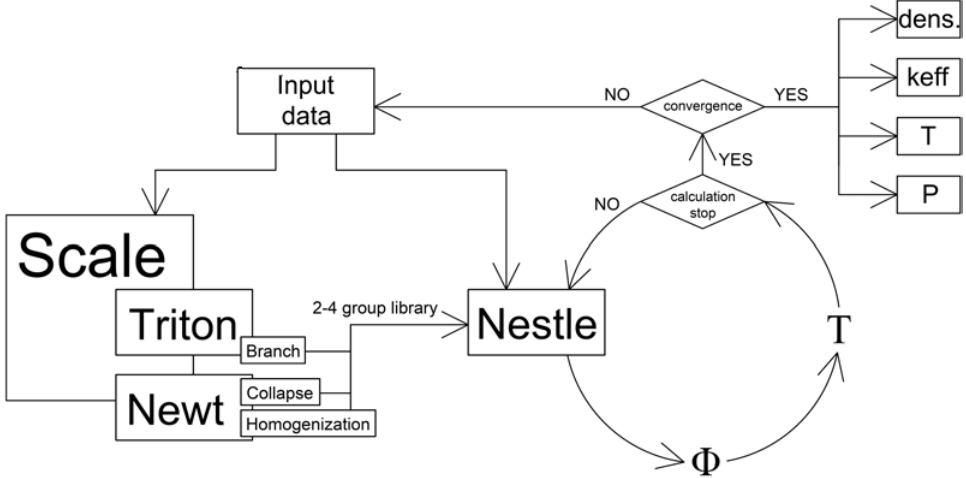
Figure 1. Calculation iteration scheme of the